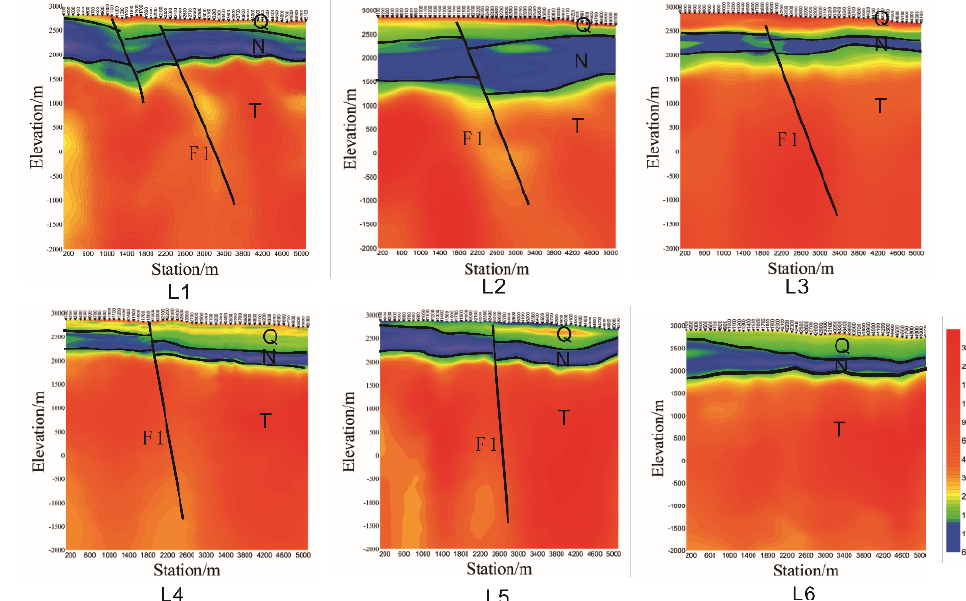
Figure 5. Inversion results of the WFEM data for Lines L1–L6.